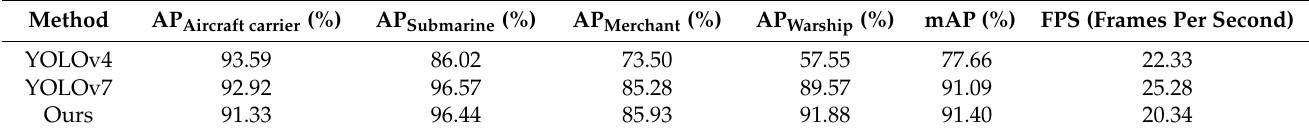
Table 4. Comparison of the accuracy and speed of different